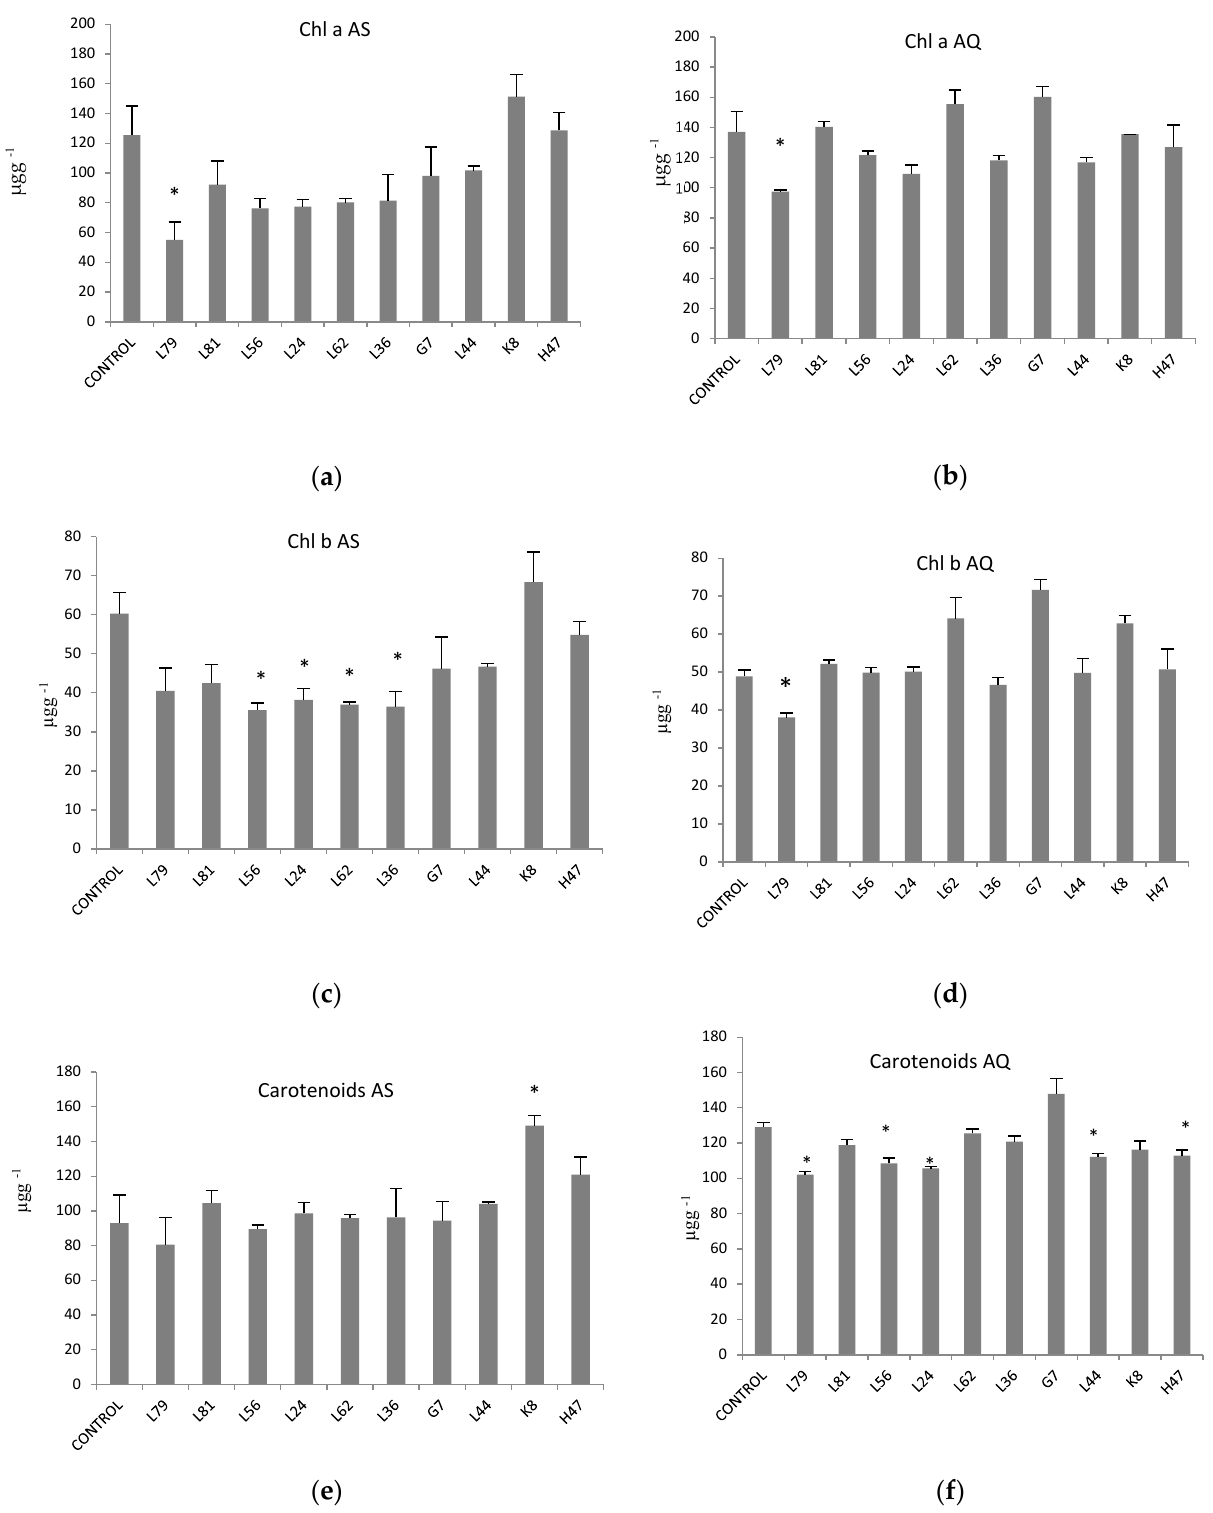
Figure 2. Photosynthetic pigments ( µ g g − 1 FW) ( a ) chlorophyll a AS, ( b ) chlorophyll a AQ ( c ) chlorophyll b AS, ( d ) chlorophyll b AQ, ( e ) carotenoids AS and ( f ) carotenoids AQ in leaves of plants inoculated with the 10 strains and non-inoculated controls. Values are the average ± SE (n = 3). Asterisks (*) indicate significant differences with the controls according to T student ( p < 0.05). Effects of PGPB on osmolytes (proline and soluble sugars) was evaluated. Proline was not affected by any treatment in any of the two varieties (Figure S1) but soluble sugars did (Figure 3). In AS (Figure 3a), L79, L62 and L36 increased, values being significant only with L79, while L56 decreased them. In AQ, (Figure 3b) L62 significantly increased and H47 significantly decreased them.